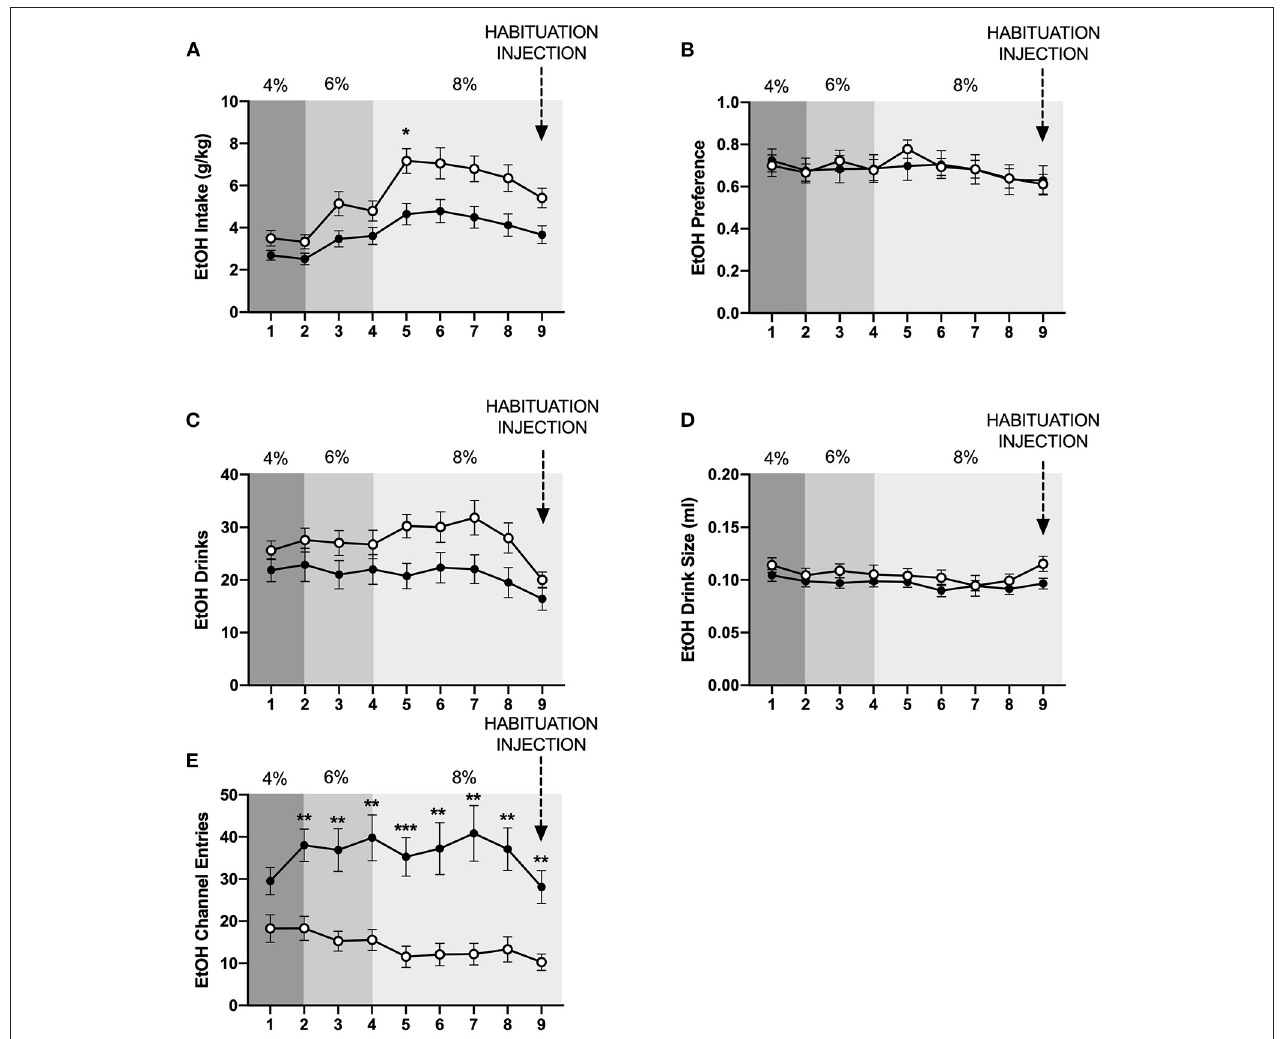
FIGURE 2 | Cumulative 24 h baseline ethanol data. (A) Ethanol intake in g/kg. (B) EtOH preference. (C) Number of ethanol drinks. (D) Ethanol drink size in mls. (E) Ethanol channel entries. Overall, socially-housed mice consumed significantly more g/kg ethanol than individually-housed mice, and this higher level of consumption is due to a trend-level increase in number ethanol drinks and ethanol drink size in the socially-housed group. However, no differences in ethanol preference were observed. Additionally, individually-housed mice made significantly more non-consummatory ethanol channel entries than socially-housed mice. * p < 0.05, ** p < 0.01, compared to opposite housing condition. Data represented as mean ± SEM. n =